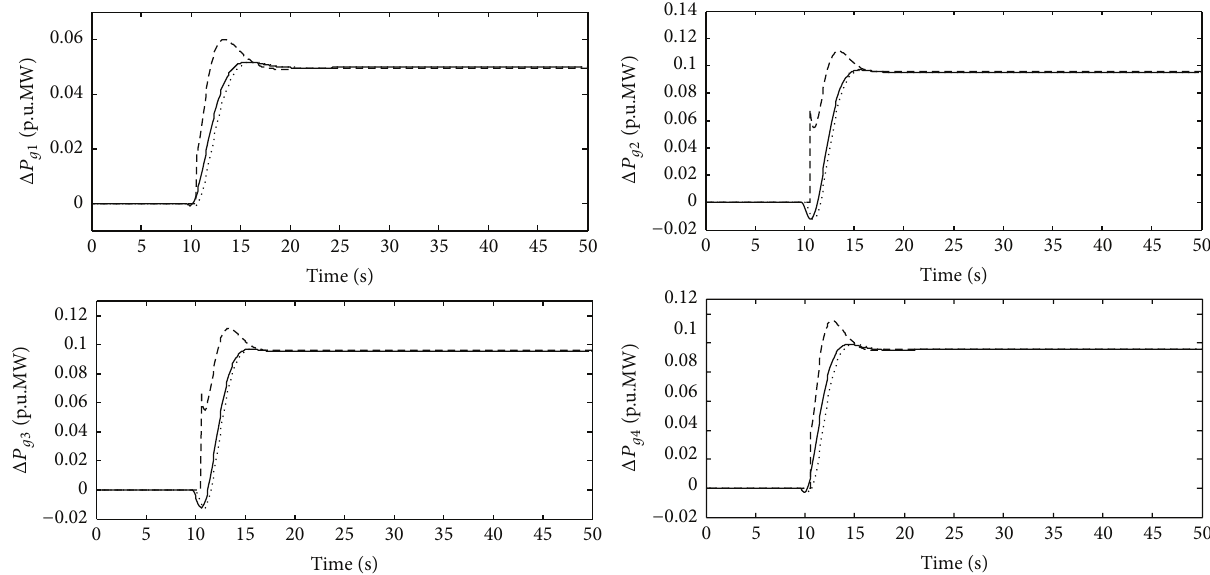
Figure 15: Response of generated power deviation in Case 2: distributed MPC (solid line), centralized MPC (dotted line), and decentralized MPC (dashed